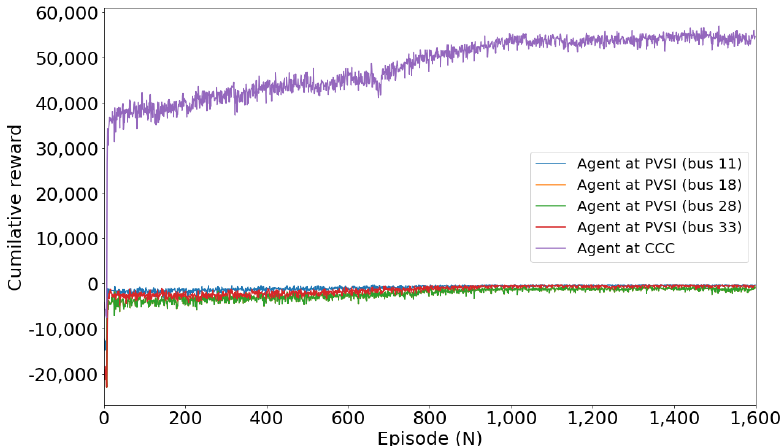
Figure 4. Cumulative reward during the training procedure of HMA-DRL in January.